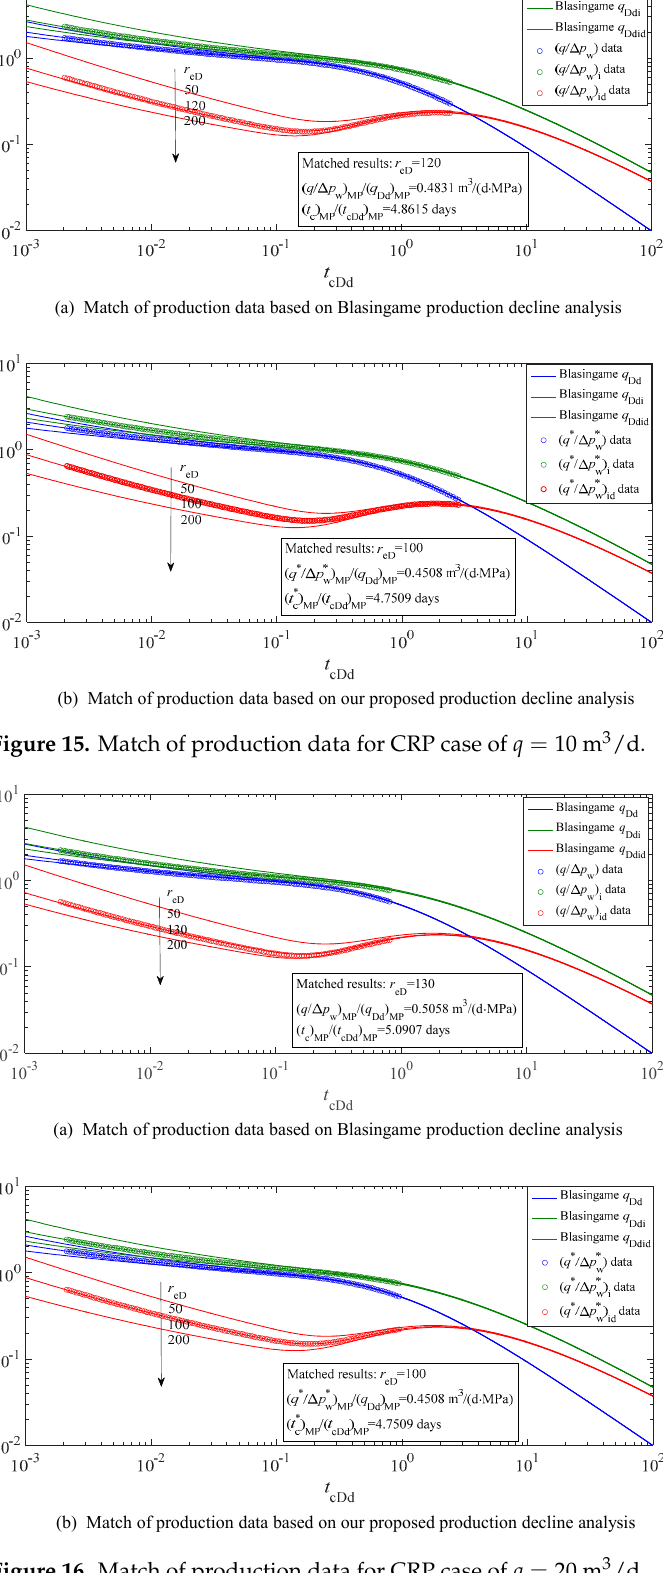
Figure 17. Match of production data for CRP case of 3 30 m d = q . (b) Match of production data based on our proposed production decline analysis (a) Match of production data based on Blasingame production decline analysis